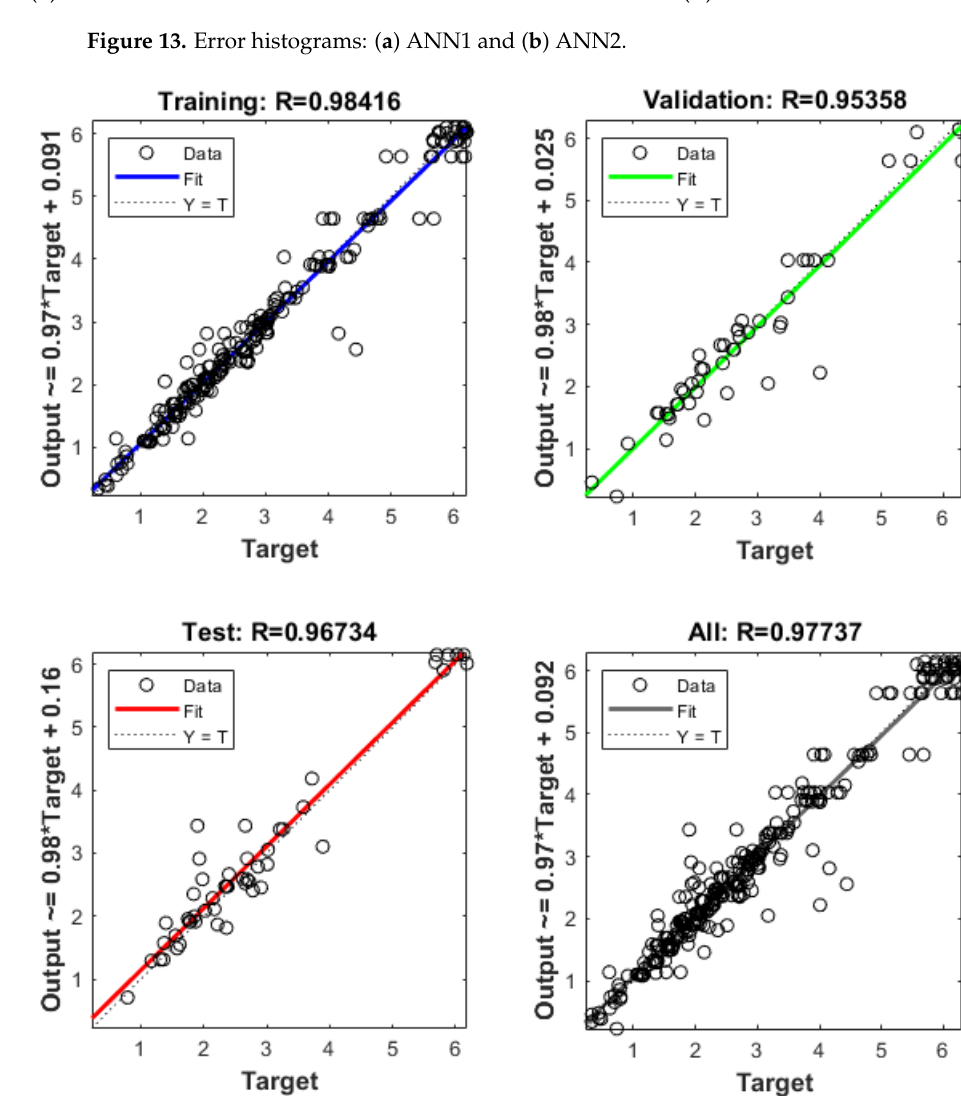
Figure 14. Linear regression between compressive strength target values and ANN1 actual outputs.